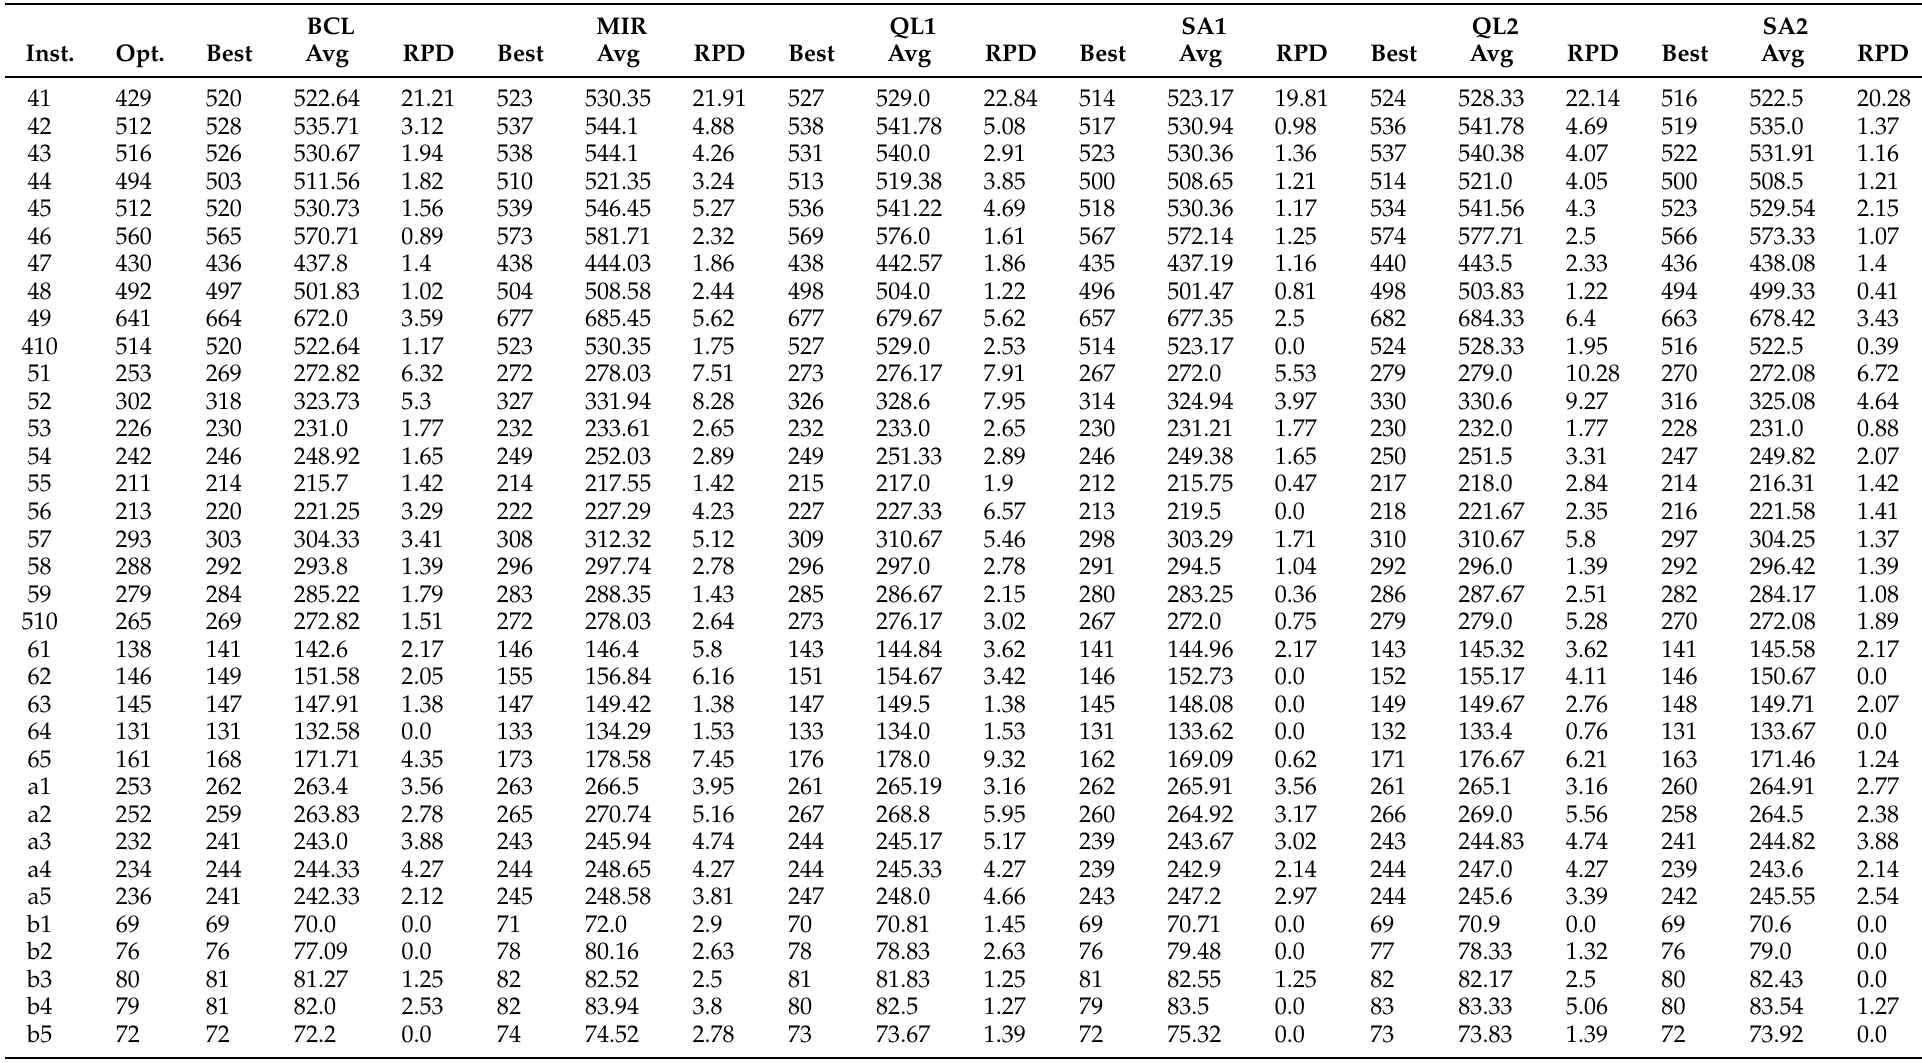
Table 13. Result comparison with HHO employing the approaches BCL, MIR, QL1, SA1, QL2, and